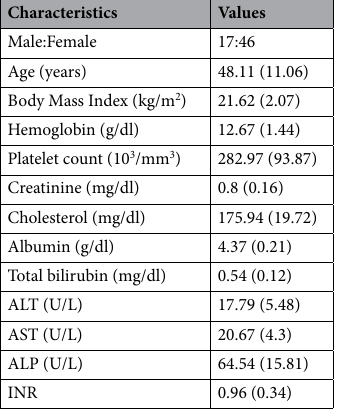
Table 2. Baseline characteristics of the 63 normal volunteers. Data are expressed as mean (standard deviation) or number (%). ALT = alanine aminotransferase, AST = aspartate aminotransferase, ALP = alkaline phosphatase, INR = international normalized